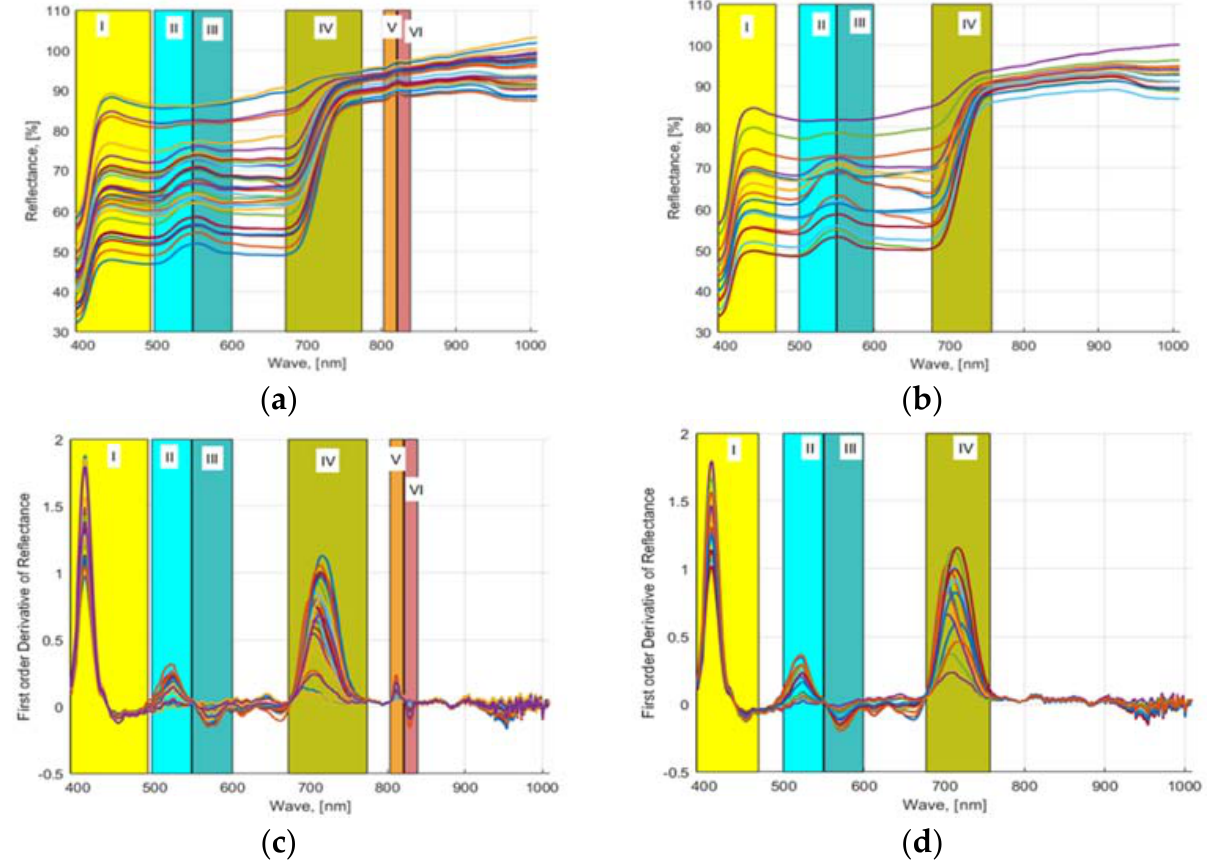
Figure 4. NDS and FDR indices: ( a , b ) HSI reflectance values from 32 freshly cut leaves of four lettuce cultivars (Black Seeded Simpsons, Parris, Rex RX, Tacitus) grown in hydroponic tubs and NFT system with different N concentrations and ( c , d ) their computed first-order derivatives.